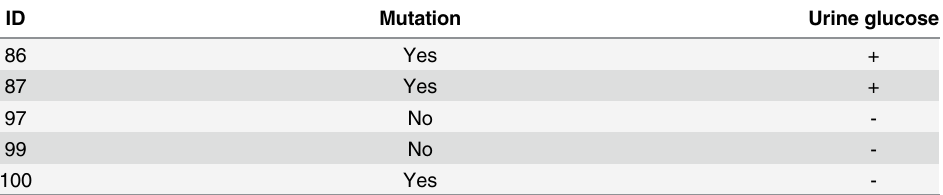
Table 2. The p.A343V mutation in the family of the index case (No